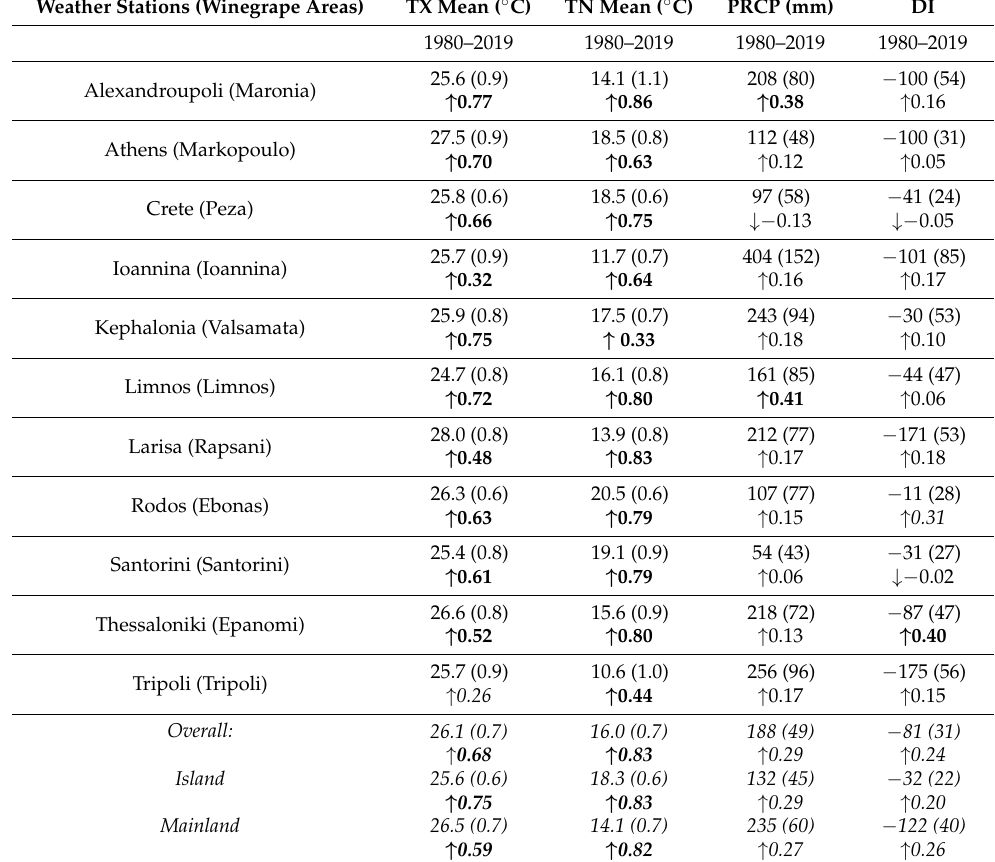
Table 3. Descriptive statistics for climate variables for the historical time window 1980–2019 during the growing season (GS: April–October) [first row of each weather station corresponds to mean values and standard deviation in parenthesis while direction ( ↑ or ↓ ) and Spearman’ rho for each variable are presented in the second row, respectively] for 11 principal winegrape areas in Greece. Bold digits indicate statistically significant trends ( p -value < 0.05), while italicized bold digits indicate lower statistical significance ( p -value <